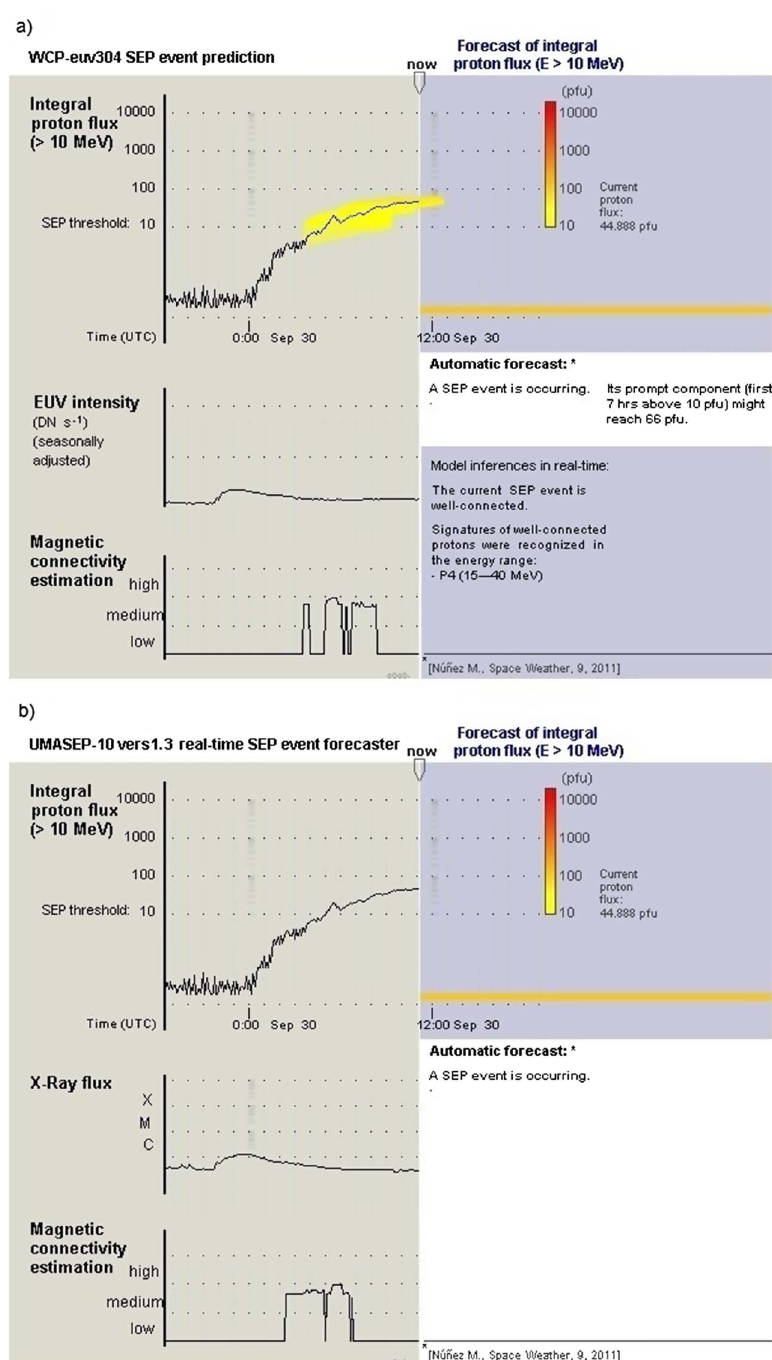
Fig. 3. This fi gure presents the predictions of (a) the WCP-euv304 and (b) the WCP-sxr (v1.3) models for the event that took place at 5:05 UT on September 30, 2013. Note that both models correctly detected a magnetic connection. Unlike the WCP-euv304 model, WCP-sxr missed the event because the condition regarding the threshold f (i.e., the minimum EM fl ux necessary to trigger a prediction) was not met. The SXR peak fl ux of the associated fl are was 1 (cid:3) 10 (cid:1) 6 W m (cid:1) 2 , which was not higher than the f threshold of the WCP-sxr model, which is 4 (cid:3) 10 (cid:1) 6 W m (cid:1) 2